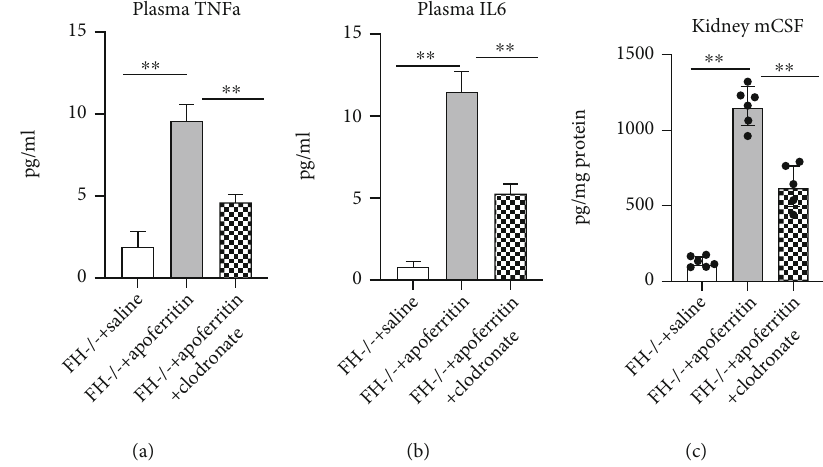
Figure 6: M ϕ s modulate cytokines in FH-dependent ICGN. The plasma and kidneys obtained at the time of sacri fi ced were stored at -80 ° C and processed as given in Materials and Methods. The concentrations of plasma TNF α (a), plasma IL-6 (b), and kidney M-CSF (c) were determined by ELISA. Results are representative of multiple experiments. ∗ P < 0 : 05 , ∗∗ P < 0 : 01 , and ∗∗∗ P < 0 : 001